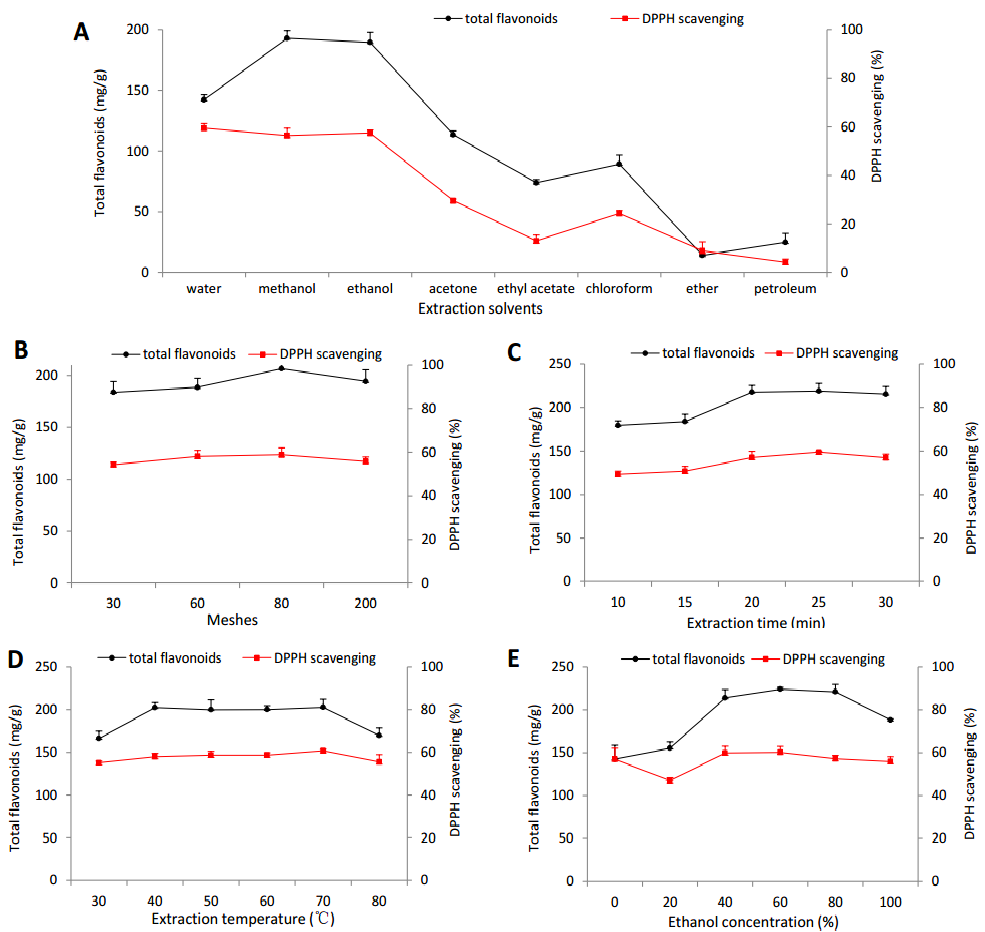
Figure 1. Influence of the main factors ( A . extraction solvents, B . meshes, C . extraction time, D . extraction temperature, E . ethanol concentration) on flavonoids and DPPH scavenging of Aurantii fructus .